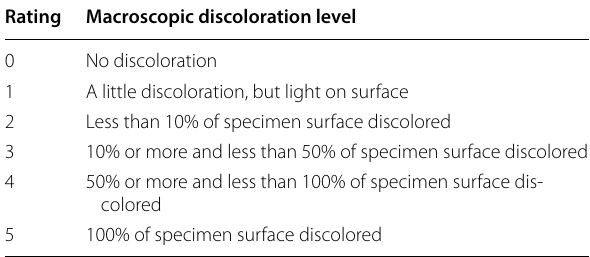
Table 2 Rating scale for the discoloration of